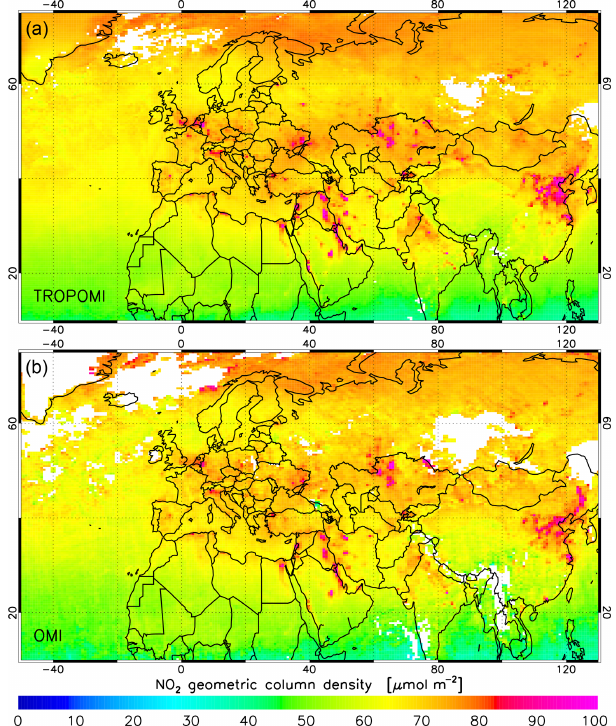
Figure 1. NO 2 geometric column density (GCD, defined in Sect. 4) from TROPOMI (a) and OMI–QA4ECV (b) averaged over 20– 26 July 2019 on a common longitude × latitude grid of 0 . 8 ◦ × 0 . 4 ◦ . Only clear-sky ground pixels (i.e. with cloud radiance fraction < 0 . 5) are used. The OMI data are filtered for the row anomaly (Sect.